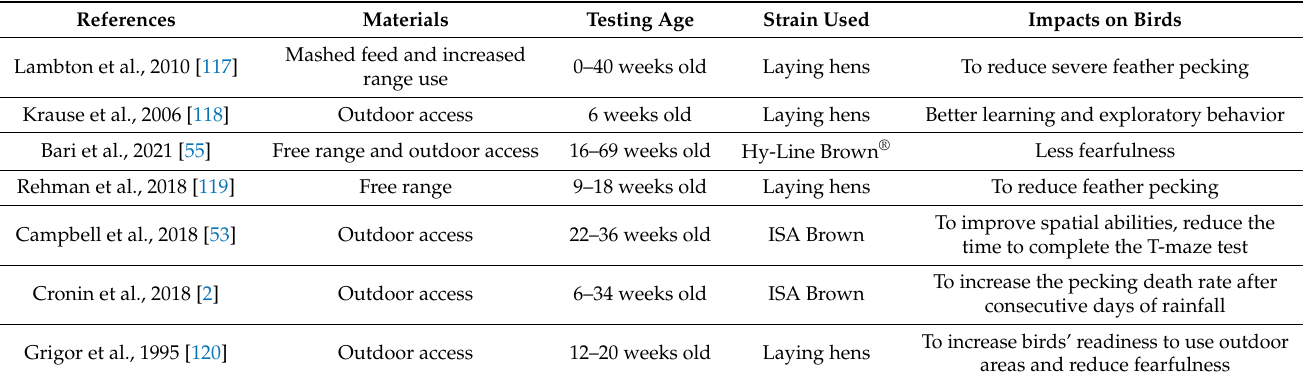
Table 4. Effects of outdoor access on chickens in different